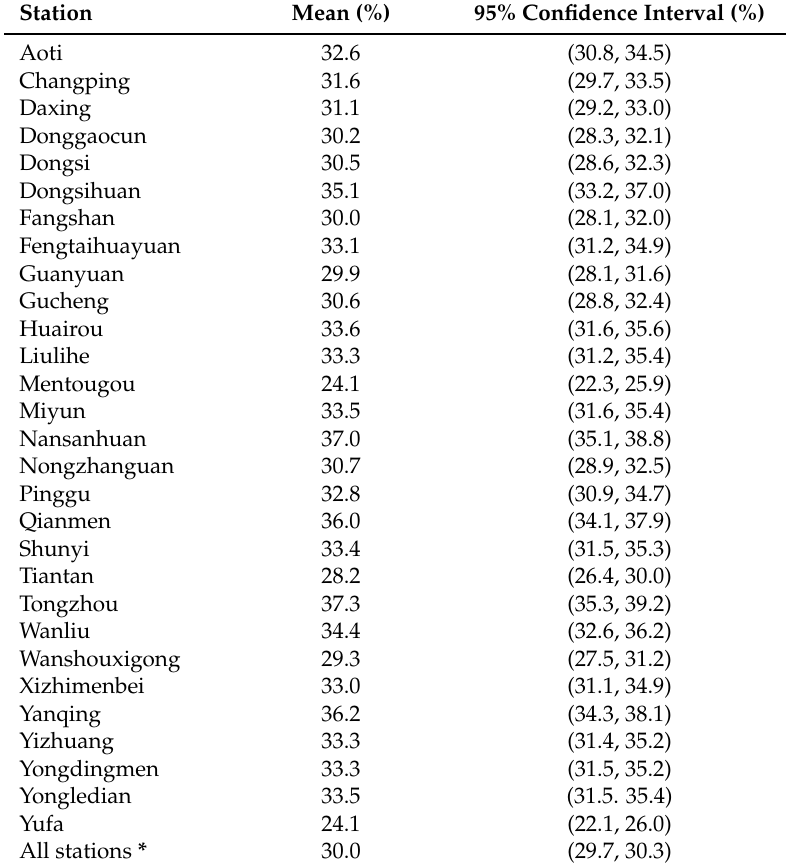
Table 7. Contribution (%) of road traffic to PM 2.5 concentrations of other stations.